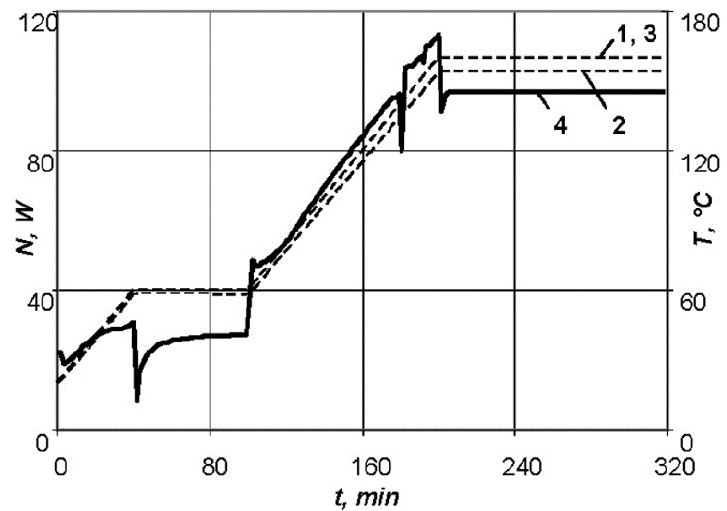
Figure 11. Dependences of parameters of the standard conditions of moulding for a patch of 2 mm thick: 1 — temperature versus time on the lower surface of the product; 2 — temperature versus time on the upper surface of the product; 3 — temperature versus time for the standard conditions; 4 — power versus time.